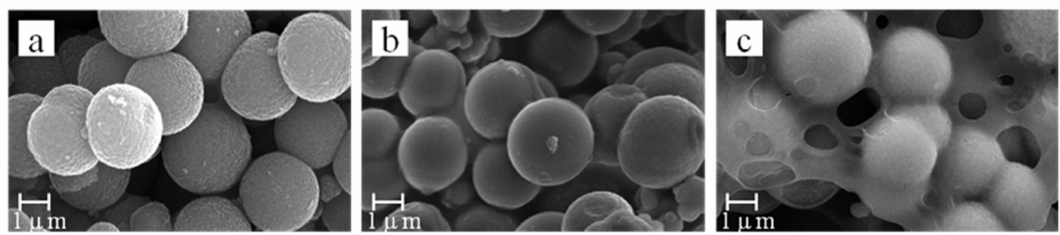
Figure 3. SEM micrographs of bifunctional TiO 2 sheets with di ff erent mass ratios of cellulose acetate (CA) and TiO 2 : ( a ) 0.05:1; ( b ) 0.055:1; ( c ) 0.06:1.